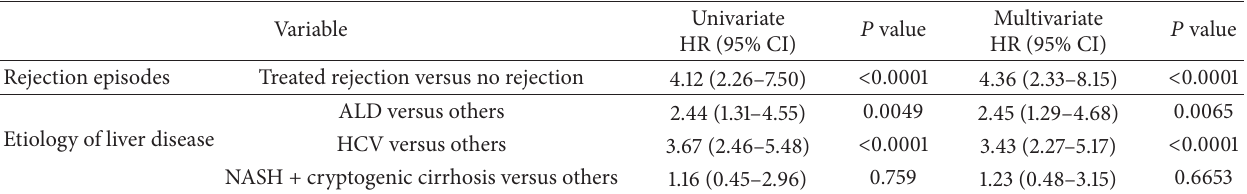
Table 3: Independent risk factors for NODAT for all LDLT recipients ( 𝑛 = 902 ).